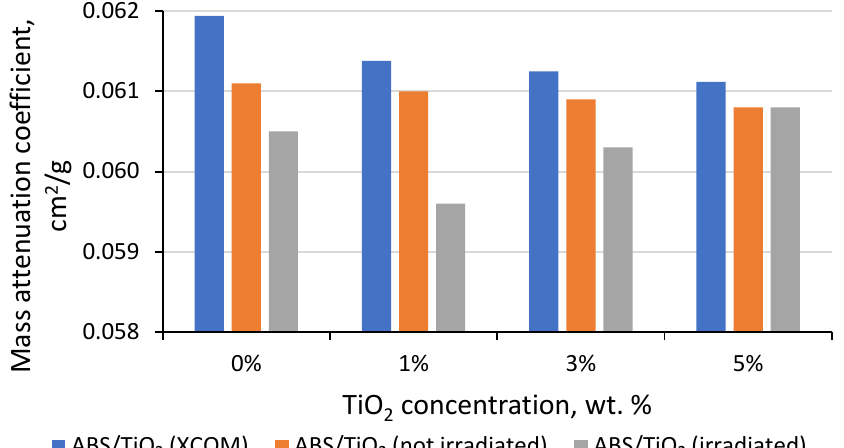
Figure 7. Mass attenuation of ABS samples with different concentrations of TiO 2 Figure 7. Mass a tt enuation of ABS samples with di ff erent concentrations of TiO 2 fi llers.